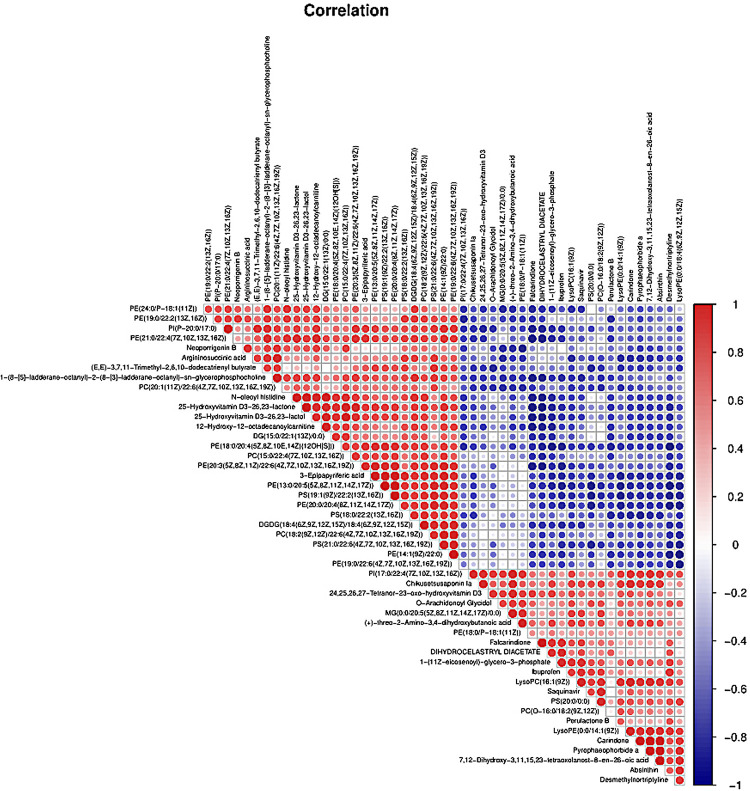
The correlation analysis of overall differential metabolites from the control (CON) and pedal peptide-type neuropeptide injected (PDP) groups. The color of each line represents the Pearson correlation coefficient of two differential metabolites. Red for positive correlation and blue for negative correlation.